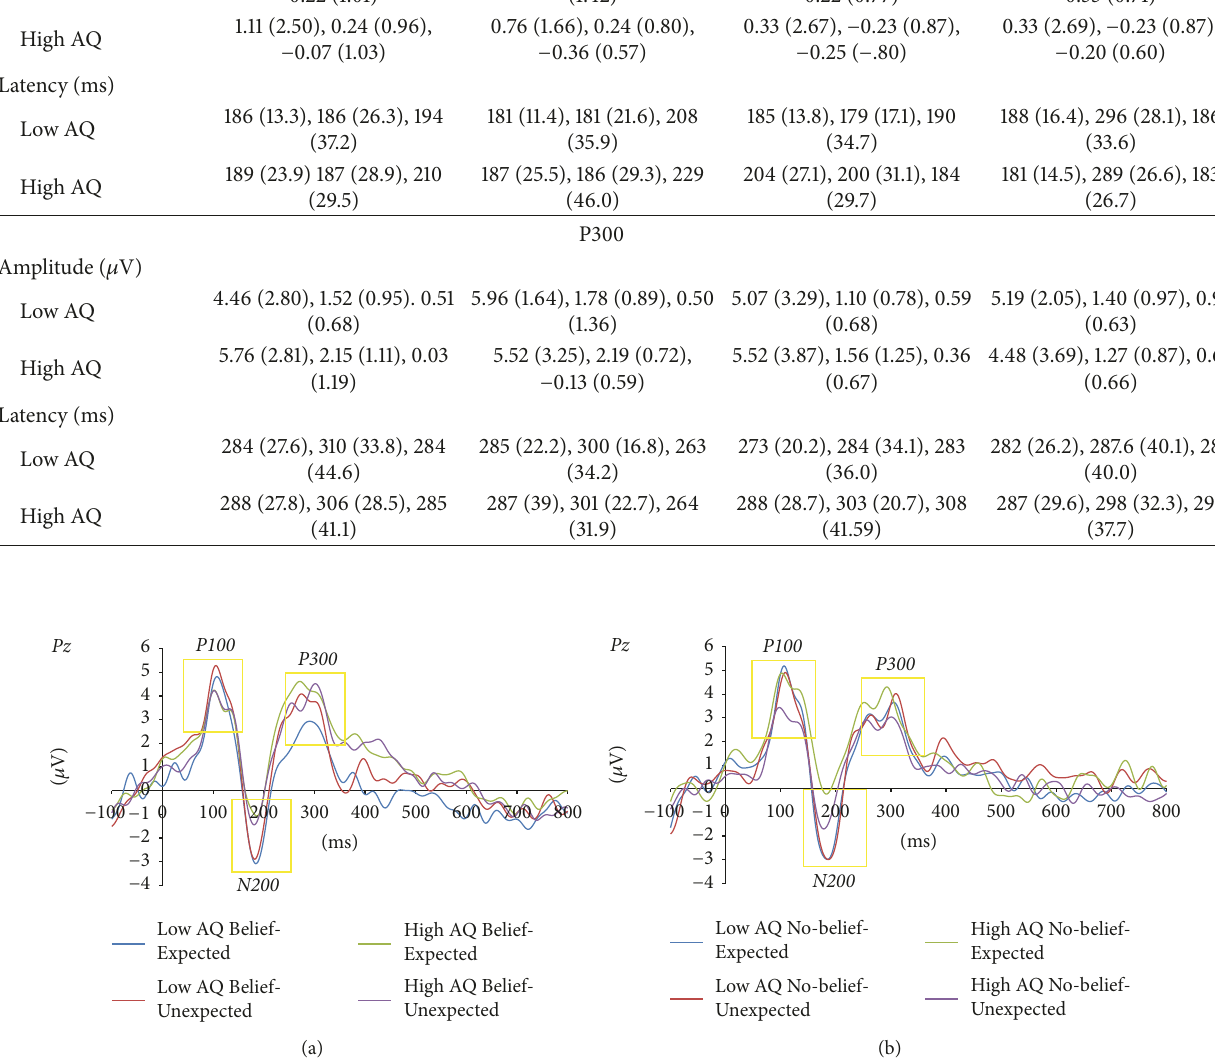
Figure 1: Grand mean ERPs on 𝑃𝑧 elicited by target words for all conditions. (a) Four conditions in the Belief story condition and (b) four conditions in the No-belief